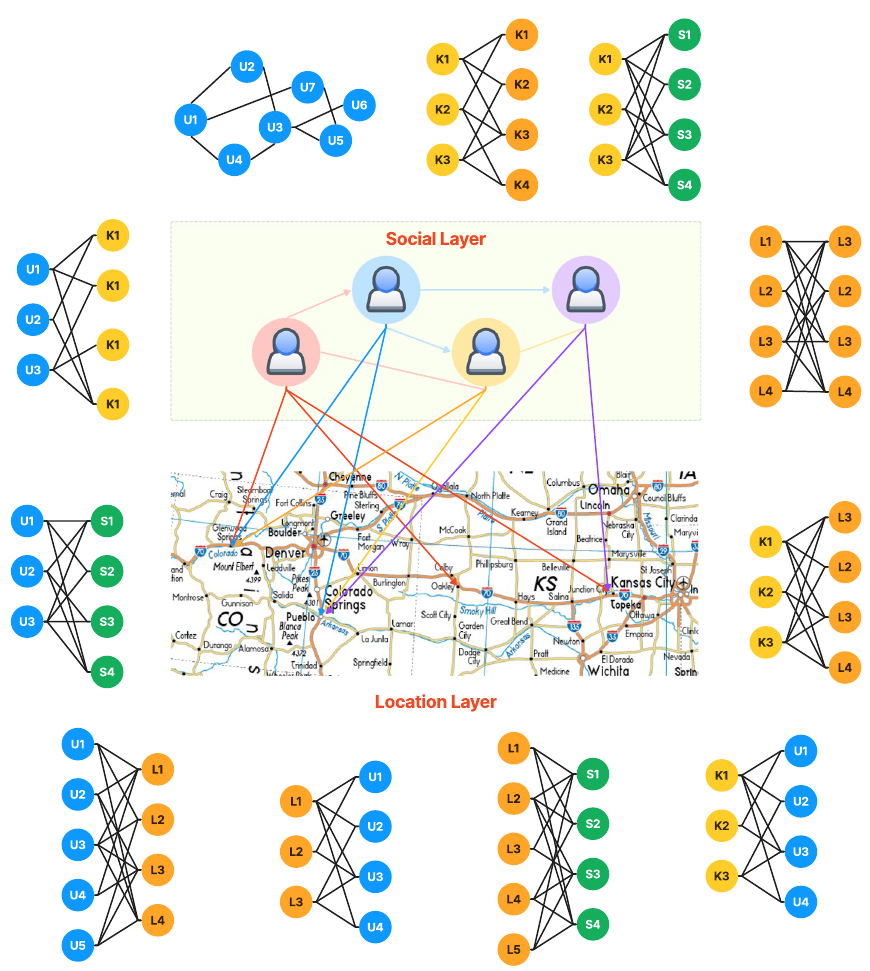
Fig. 1 All participating networks in the proposed model